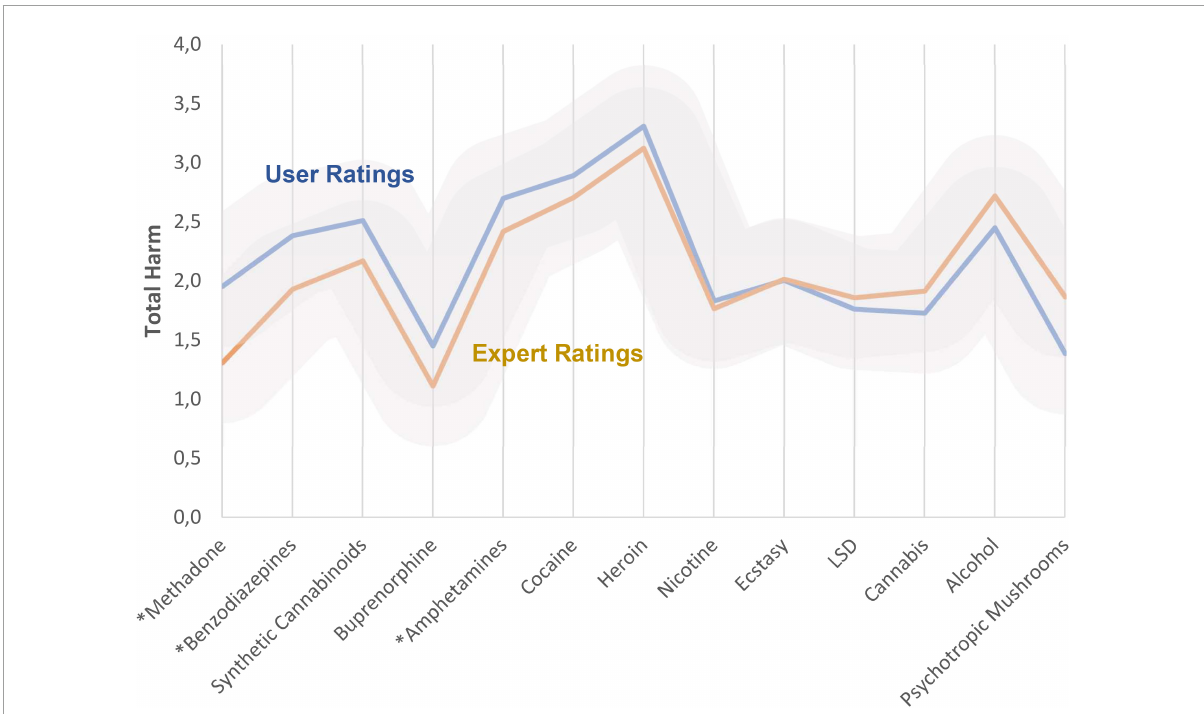
FIGURE6 Comparison between users’ and experts’ average overall harm ratings. The relative contribution of the 5 dimensions ( Supplementary Figure 1 and Supplementary Table 1 ) had been weighted by the cohorts 2 of the user and experts. See also Supplementary Figure 20 , which demonstrates the rank order. Additionally, the Supplementary Figure 19 shows the ratings for the excluded substances. * p < 0.01. Gray areas indicate standard deviations for the